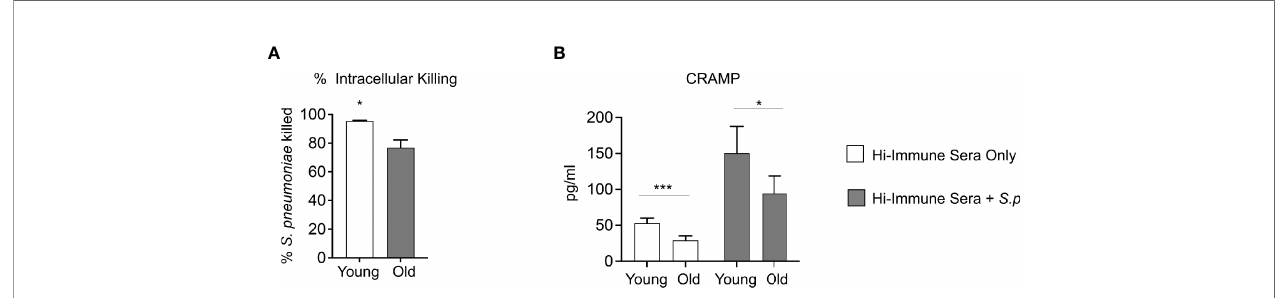
FIGURE 6 | Aging impairs intracellular killing of engulfed S. pneumoniae . (A) PMNs were isolated from the bone marrow of naïve young and old male C57BL/6 mice and infected with S. pneumoniae pre-opsonized with young heat inactivated immune sera for 15 minutes at 37°C. Gentamicin (100 m g/ml) was then added for 30 minutes to kill extracellular bacteria. PMNs were then washed and one set immediately plated on blood agar plates to determine the amounts of engulfed bacteria. The other sets of PMNs were incubated for 30 more minutes and then plated to enumerate remaining viable bacteria. The % of engulfed bacteria that was killed was then calculated. (B) PMNs from young and old naive mice were infected with S. pneumoniae pre-opsonized with young heat inactivated immune sera for 40 minutes. The cells were then lysed and assayed for CRAMP levels using ELISA. Data are pooled from (A) three separate experiments (n=3 biological replicates) where each condition was tested in triplicate (n=3 technical replicates) per experiment and (B) four separate experiments (n=4 biological replicates). *, denotes signi fi cant differences as determined by unpaired Student ’ s t test. * denotes p < 0.05, and *** denotes p < 0.001 . ns denotes not signi fi